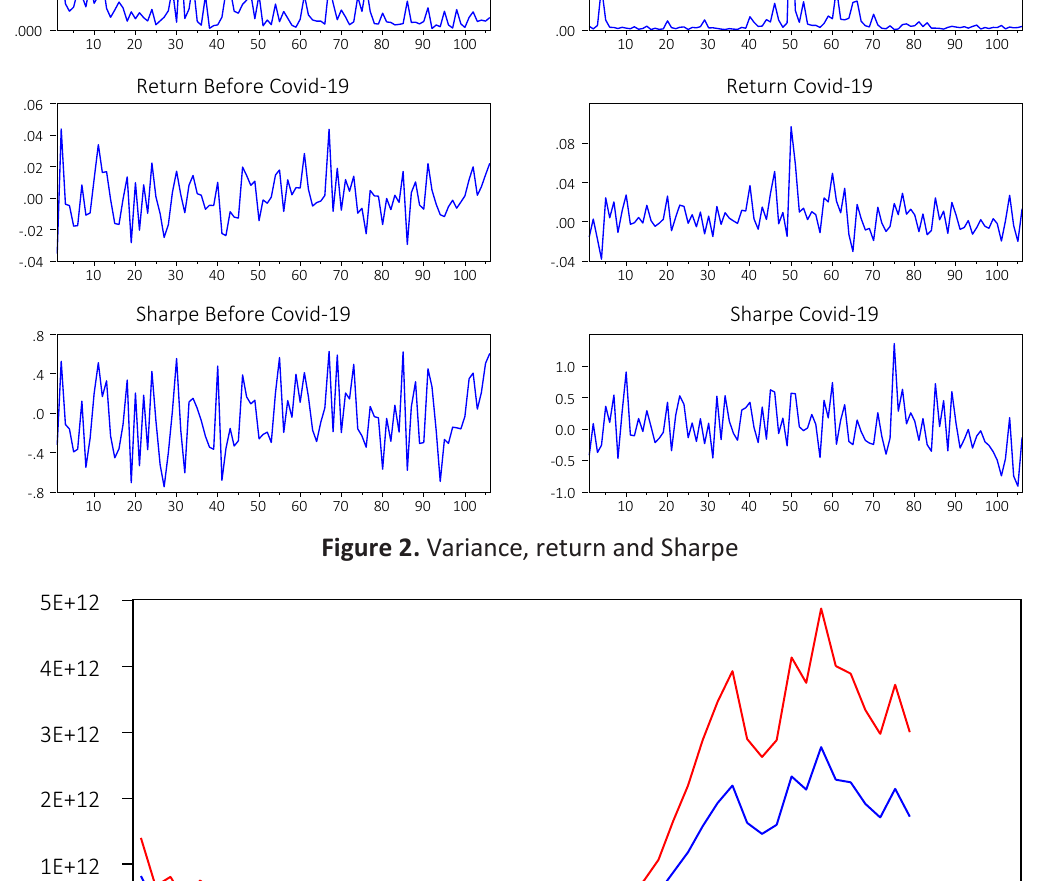
Figure 1. Volume transaction